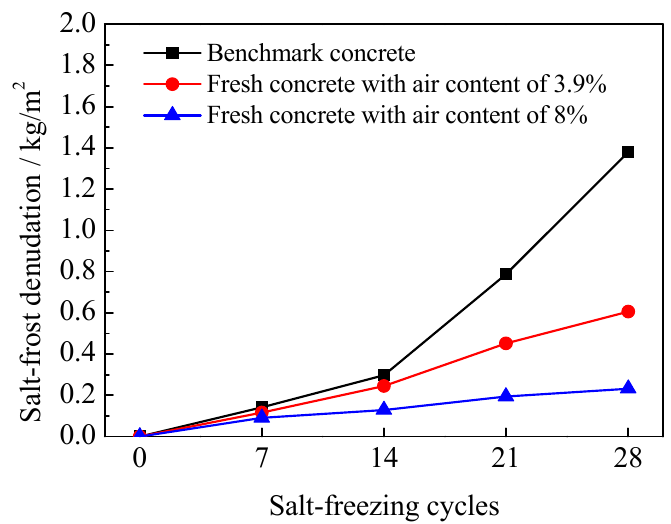
Figure 8. The change of scaled mass of the concrete with different air contents due to salt-frost. By further analyzing data of the salt-frost scaling of the concrete with different air contents after 28 cycles, as presented in Figure 9, it is found that the scaled mass of the concrete due to salt-frost reduces [15] in the form of a power function with the increase of air content and the correlation coefficient is up to 0.78. When the air content of fresh concrete is higher than 6%, the trend of the scaled mass of the concrete decreasing with the rise of air content gradually slows down.